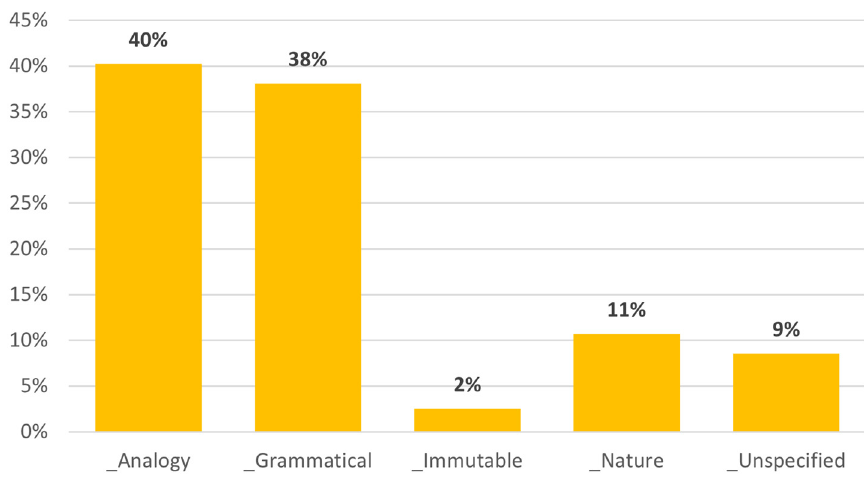
Figure 7. Relative frequency of the lower-level categories within the top-level category S YSTEM (% of total number of S YSTEM arguments, n = 281).